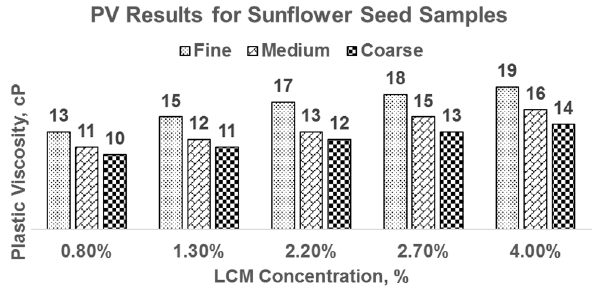
Fig. 2 Plastic viscosity results for sunflower seed samples